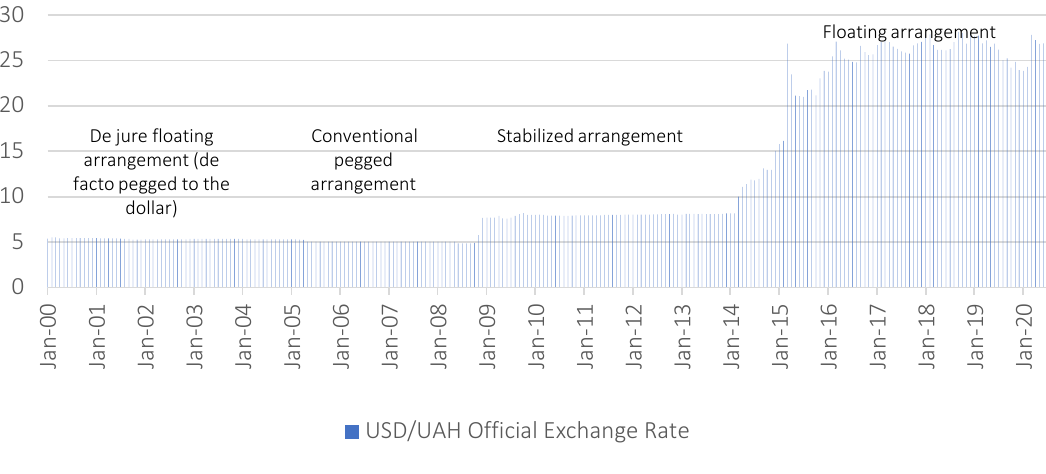
Figure 1. Dynamics of the USD/UAH official exchange rate, 2000 – May